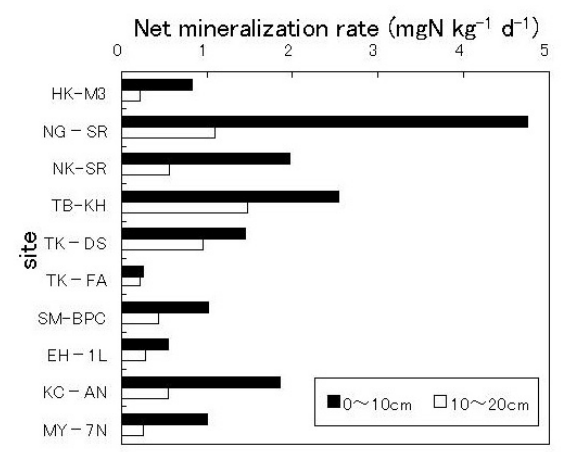
FIGURE 3 . Net mineralization rates of N in soil (6 weeks, 25 o C) in the watersheds.